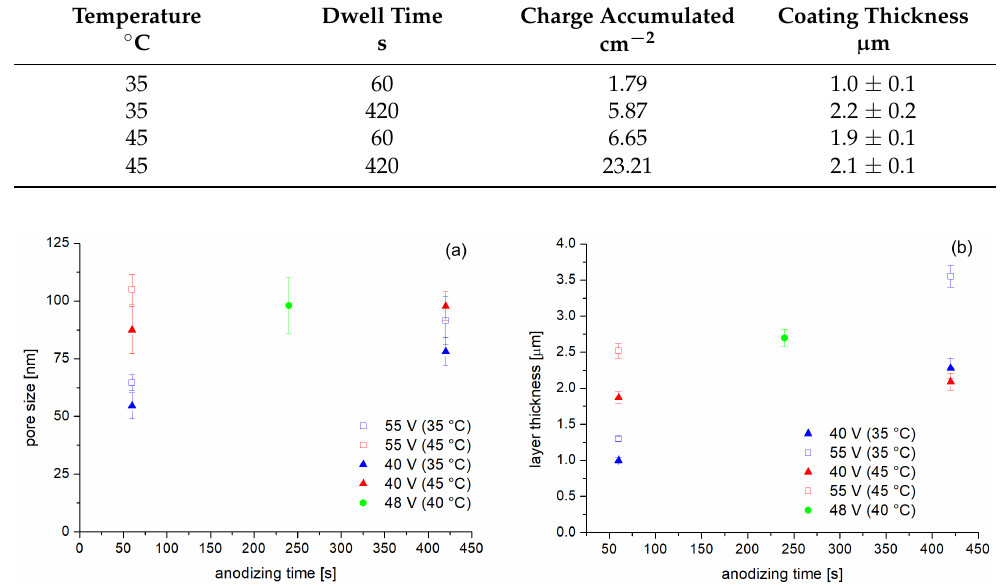
Figure 3. ( a ) Pore size and ( b ) layer thickness as a function of anodizing time at different voltages and temperatures.